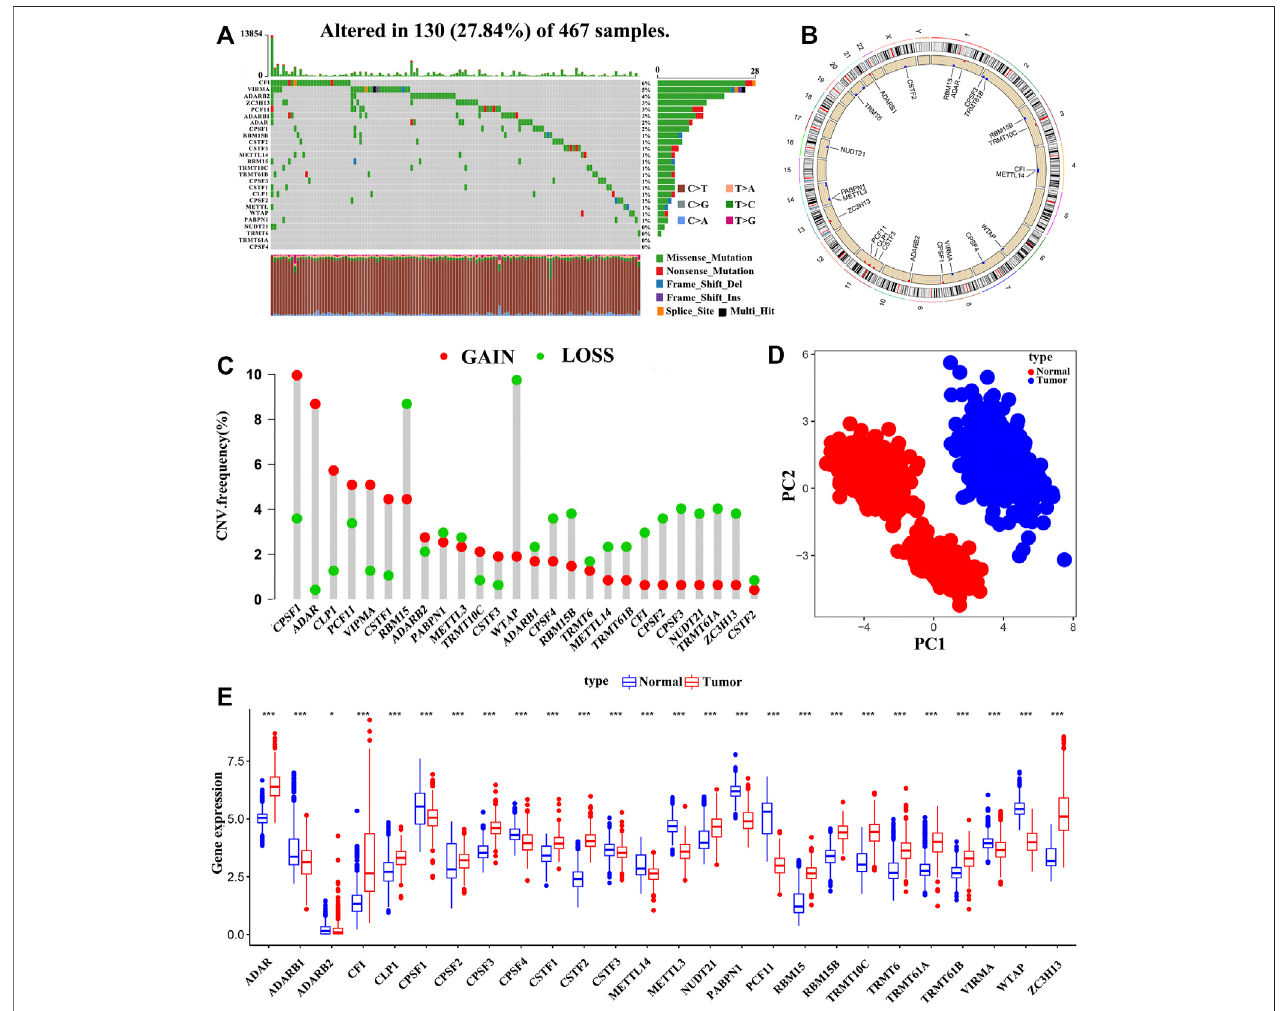
FIGURE 1 | The Genomic alterations and aberrant expression of RNA modi fi cation “ writers ” in SKCM. (A) The frequency of mutation of 26 RNA modi fi cation “ writers ” in 467 samples from the TCGA-SKCM cohort. (B) The location of copy number variation (CNV) of 26 RNA modi fi cation “ writers ” on 23 chromosomes. (C) The CNV frequency of 26 RNA modi fi cation “ writers ” in TCGA-SKCM cohort. (D) Principal component analysis based on the expression of 26 RNA modi fi cation “ writers ” to distinguish tumors (red dots) from normal tissues (blue dots) in the TCGA-SKCM and GTEx-SK cohorts. (E) The expression differences of 26 RNA modi fi cation “ writers ” between normal and tumor tissues. Tumor, red; Normal, blue. (* p < 0.05; ** p < 0.01; *** p < 0.001).